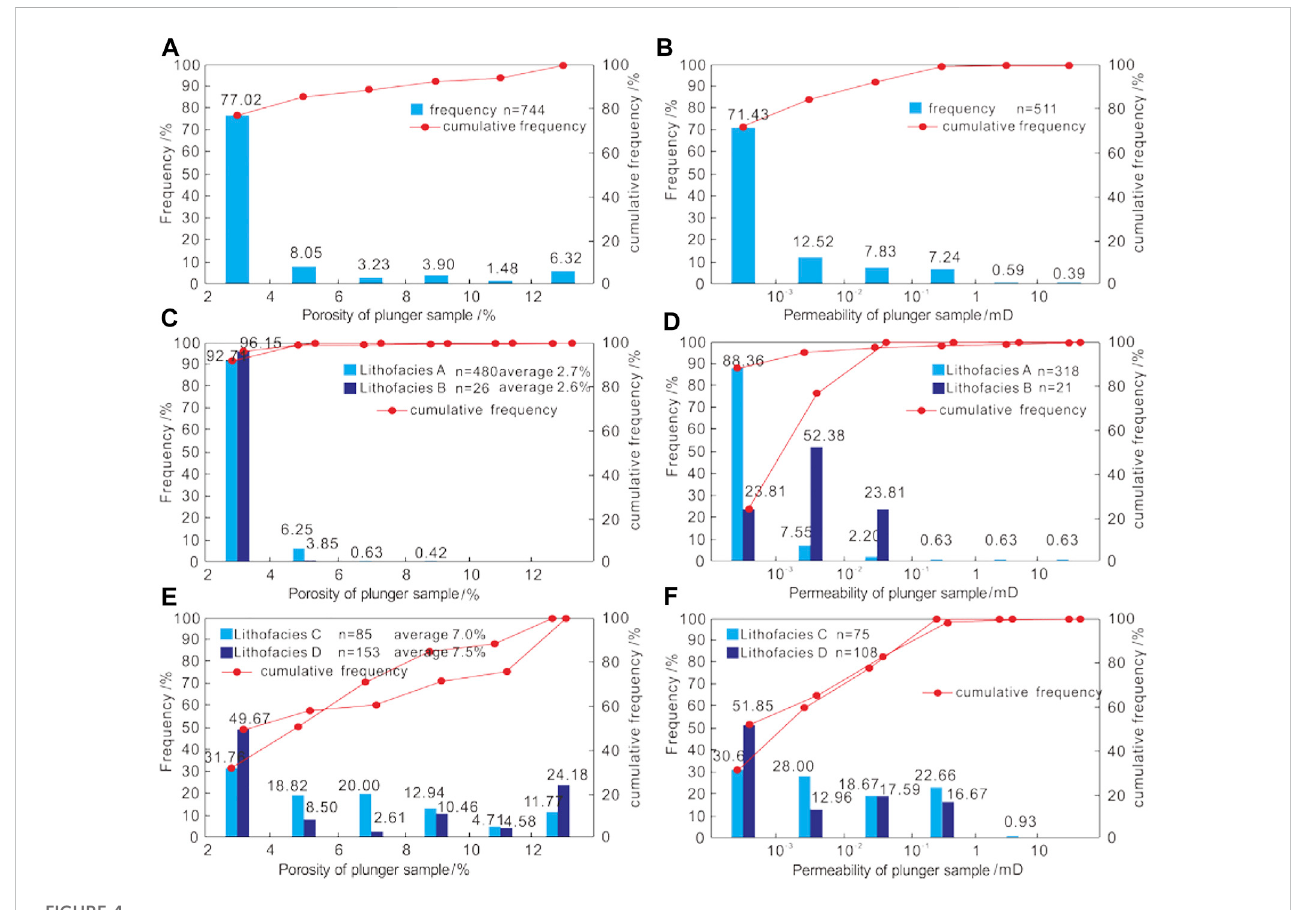
FIGURE 4 Petrophysical property of Feixianguan Formation tight oolitic